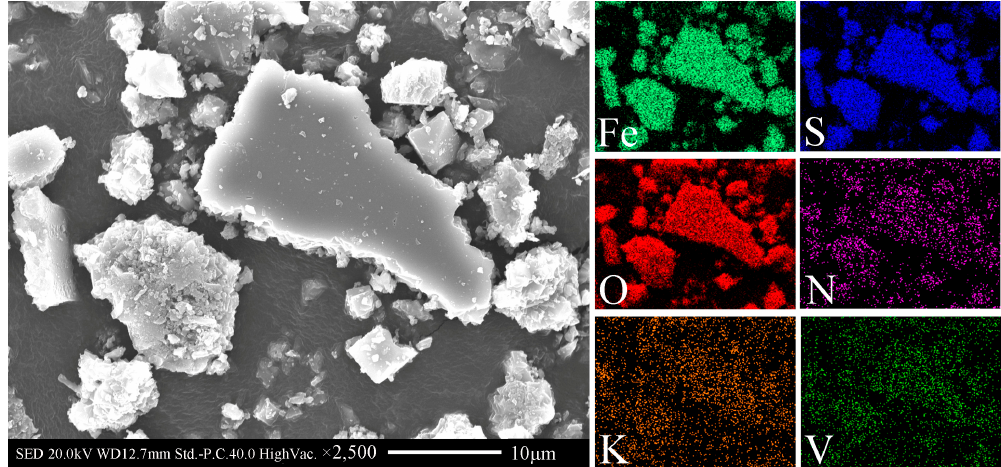
Figure 10. SEM images with EDS element mapping of jarosite generated in leaching solution.